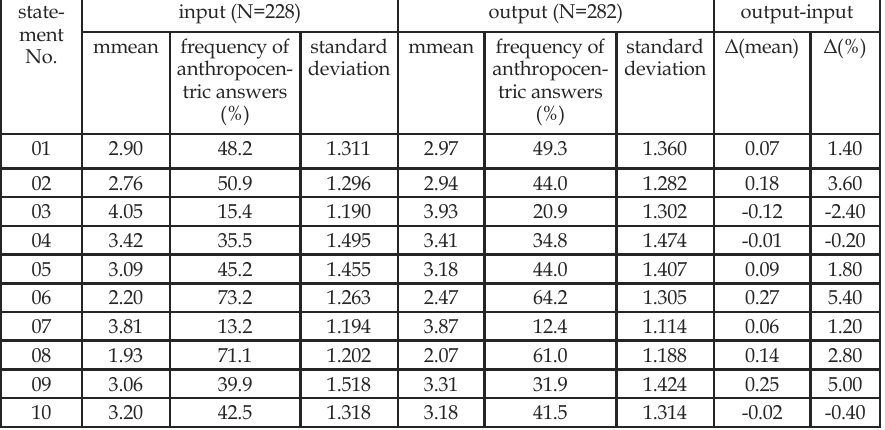
Table 1. Examples of student responses in various environmental issues 1